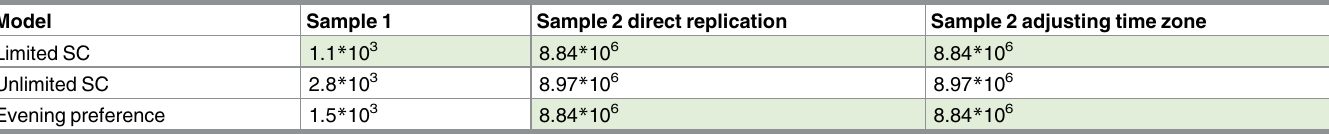
Table 1. Devianceof accuracyscores relative to theoretical models for daily patterns of